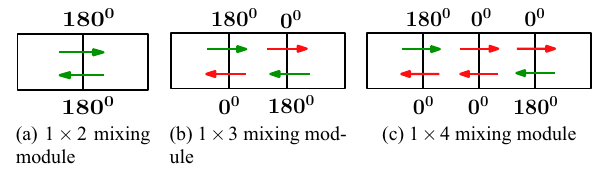
Fig. 7 Different types of existing mixing modules in 2 × N mixing